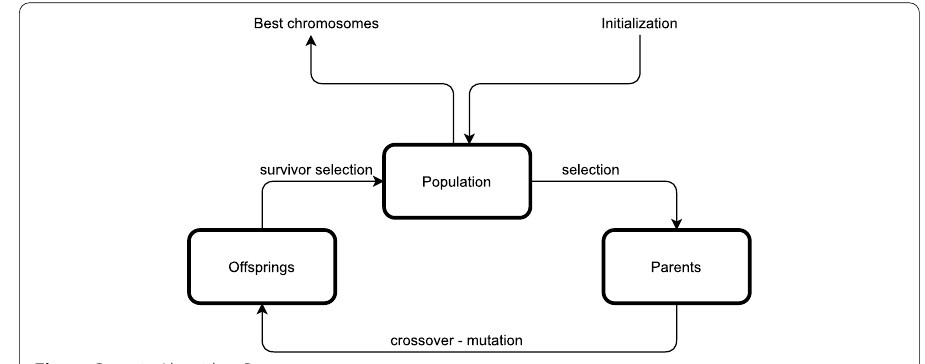
Fig. 7 Genetic Algorithm